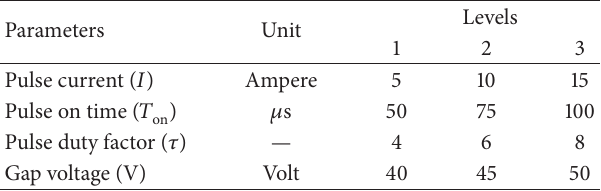
Table 2: Machining parameters and their